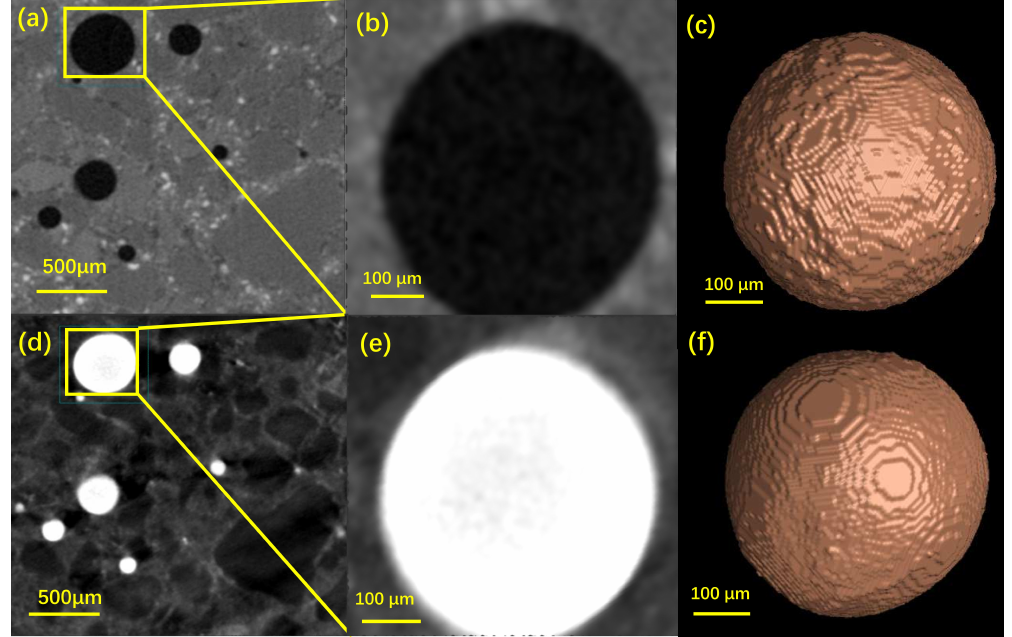
Figure 9. Representative images of a VOI in the mortar sample ( a – c ) before and ( d – f ) after mercury intrusion: ( a , d ) the 2D sectional view with ( b , e ) the magnified pore and ( c , f ) its 3D